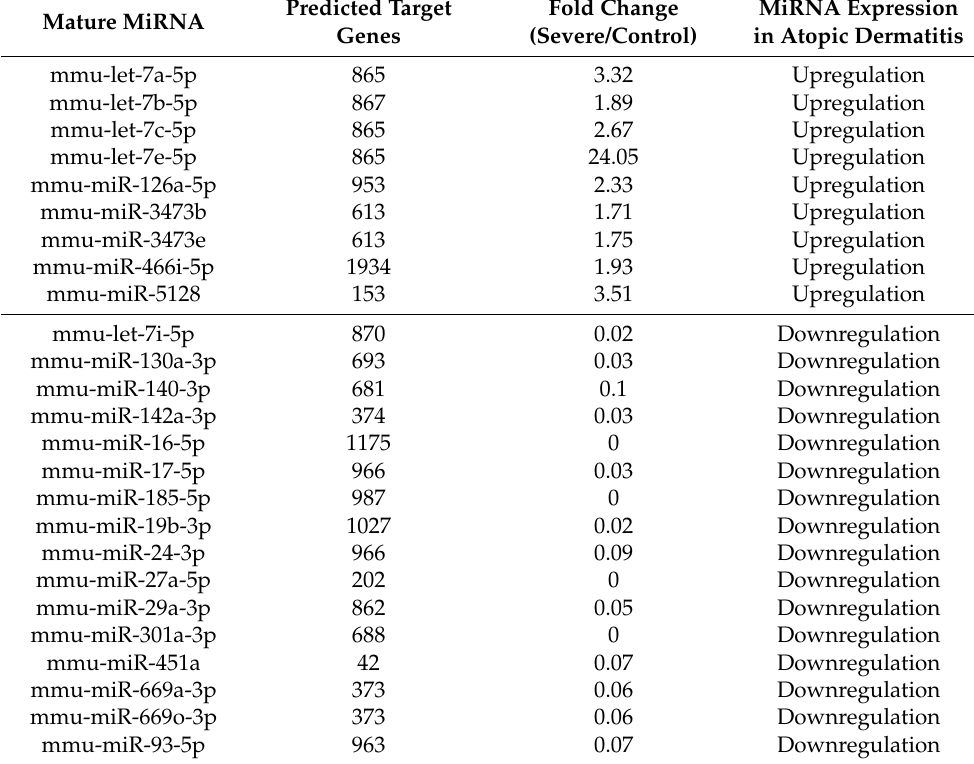
Table 1. Up/downregulation of microRNAs (miRNAs) induced by atopic dermatitis. Mature